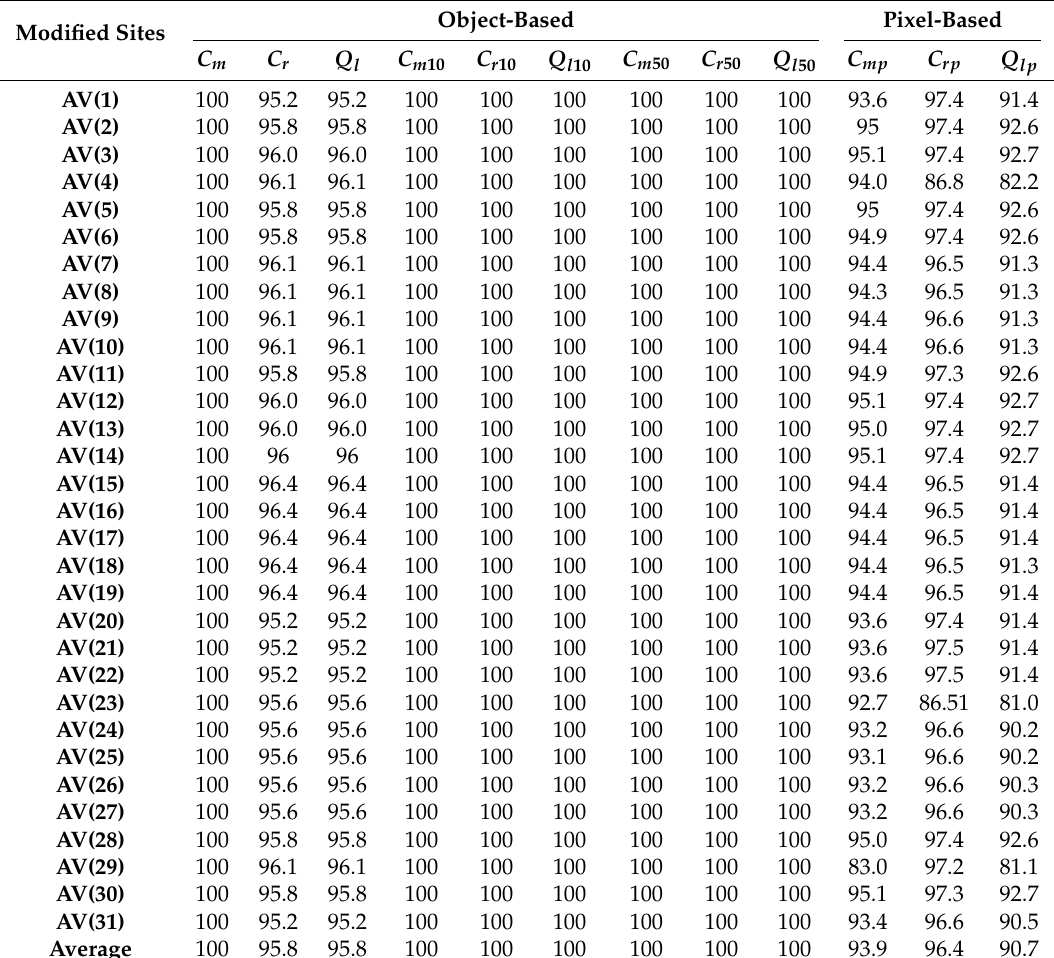
Table 4. Building change detection results for 2-D (size) changes in the AV site. Object-based: C m , completeness; C r , correctness; Q l , quality ( C m 10 , C r 10 Q l 10 and C m 50 , C r 50 Q l 50 are for building planes over 10 m 2 and 50 m 2 , respectively). Pixel-based: C mp , completeness; C rp , correctness; Q lp , quality